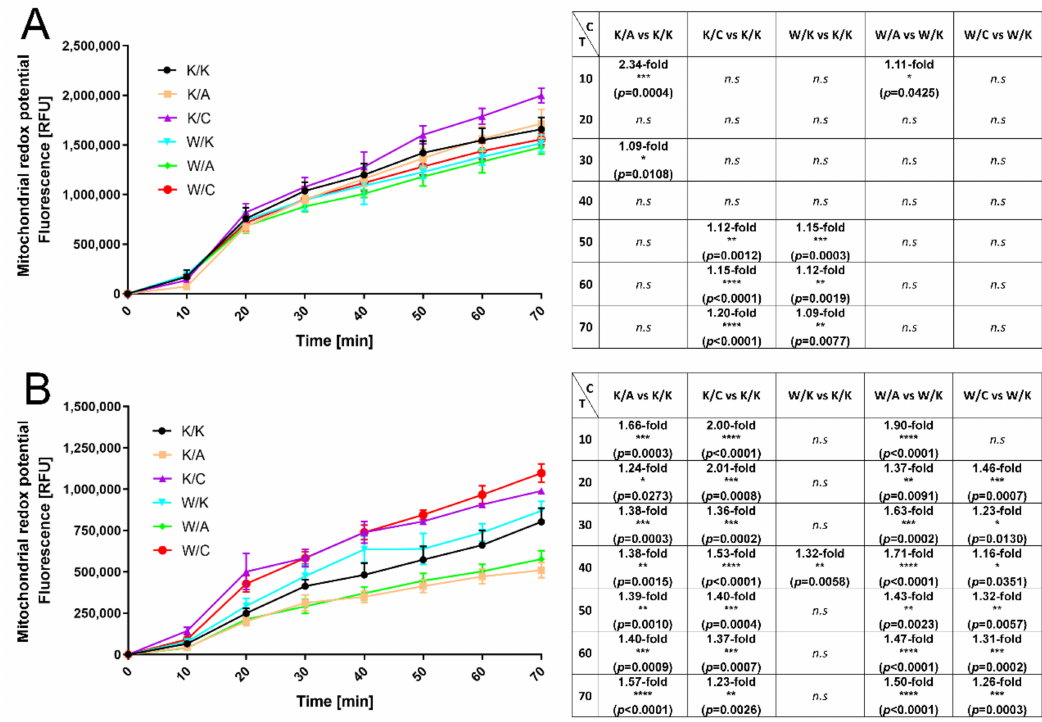
Figure 5. Evaluation of changes in mitochondrial redox potential (graphical and tabular). ( A ) HT-1376 variants. ( B ) CAL-29 variants. C—Comparison. T—Time [min]. p < 0.05 (*), p < 0.01 (**), p < 0.001 (***), p < 0.0001